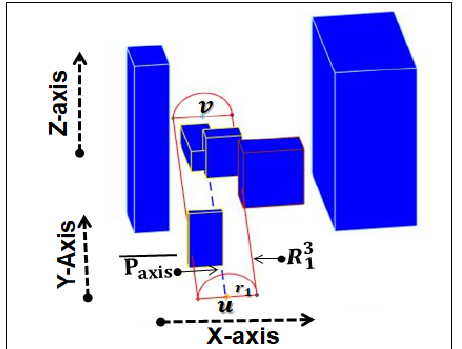
Figure 4. Circumscribed half-cylinder space ( R 3